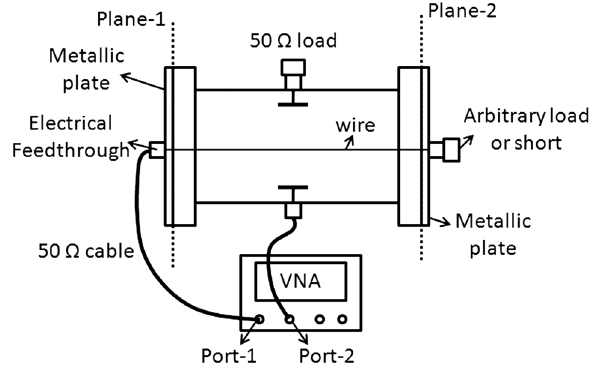
FIG. 2. Schematic of general setup of the modified coaxial wire